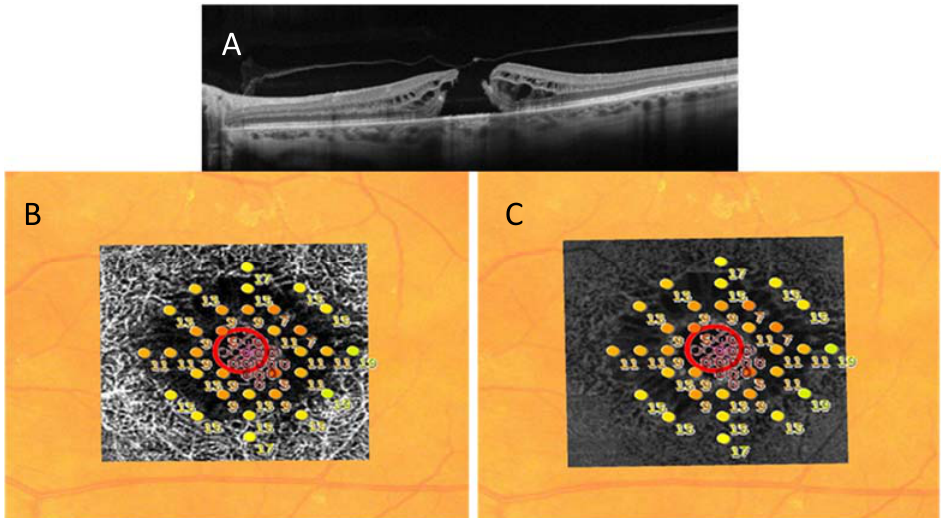
Figure 3. ( A ) The B ‐ scan OCT shows a full ‐ thickness macular hole. ( B ) The central absolute scotoma corresponding to the FTMH and rings of relative scotoma extending in the perilesional area are shown in microperimetry map. These relative scotomas correlate with the cystic alterations detected by OCT angiography at the level of deep capillary plexus ( B ) and by en face OCT in the outer plexiform layer (OPL) and the Henle fiber layer (HFL) complex ( C ).